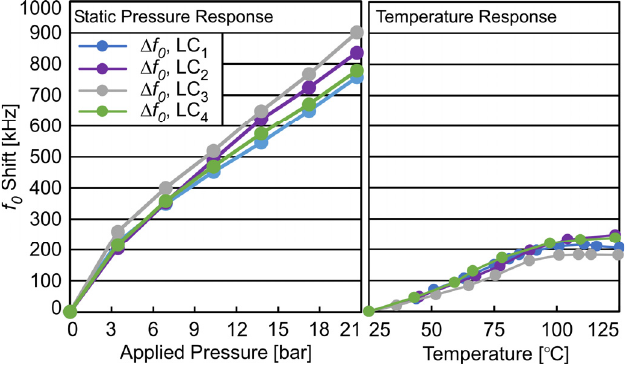
( left ) and the applied temperature ( right ). Error bars not visible at scale (95% confidence interval: ±0.041 kHz).